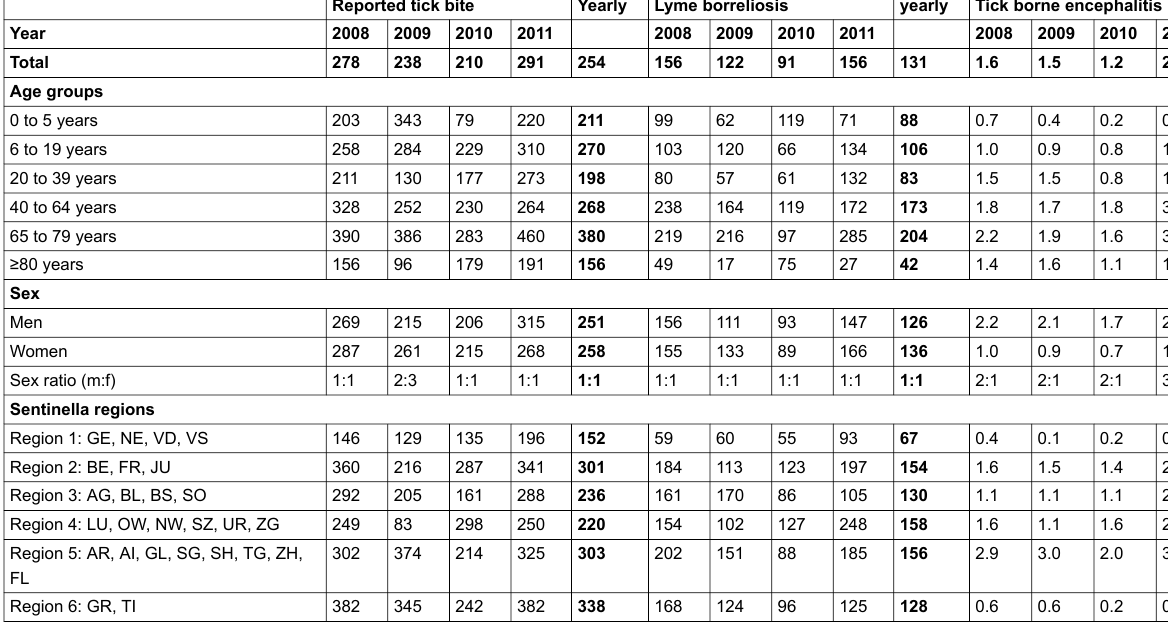
Table 1: Incidences per 100,000 inhabitants of cases of tick bites, Lyme borreliosis and tick borne encephalitis in Switzerland, 2008 to 2011. Reported tick bite